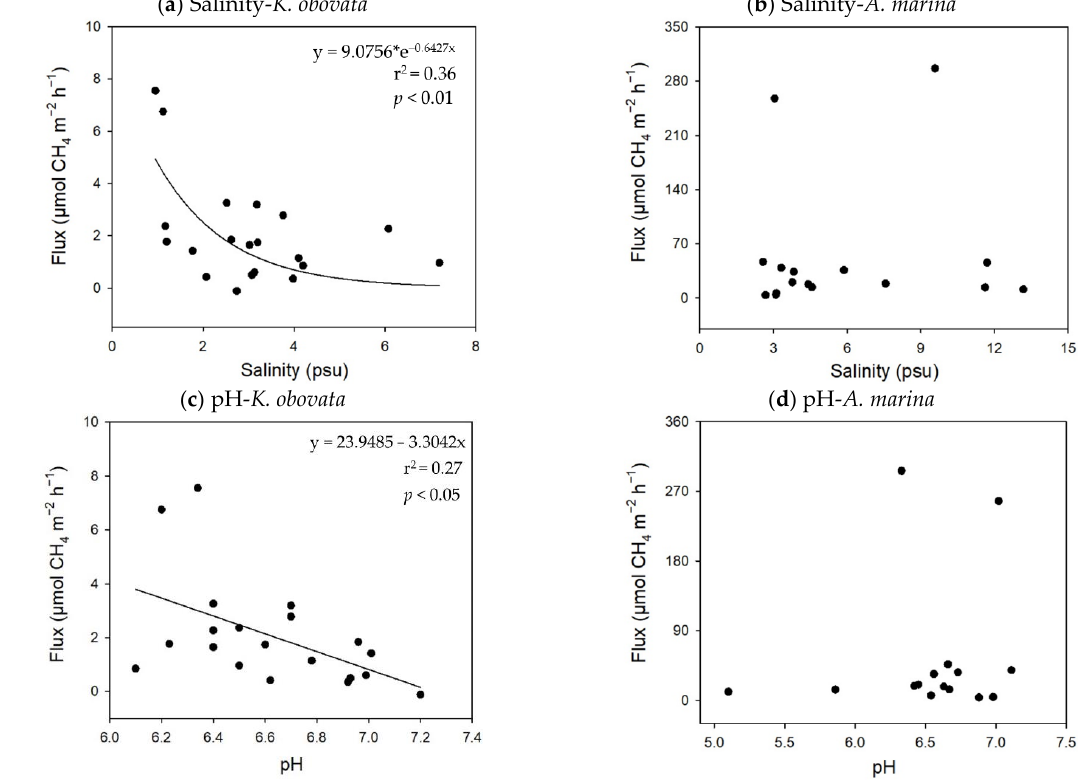
Figure 5. The relationship between soil salinity, pH, and CH 4 flux in the two mangrove species: ( a , c ) K. obovata (n = 20) and ( b , d ) A. marina (n = 16).